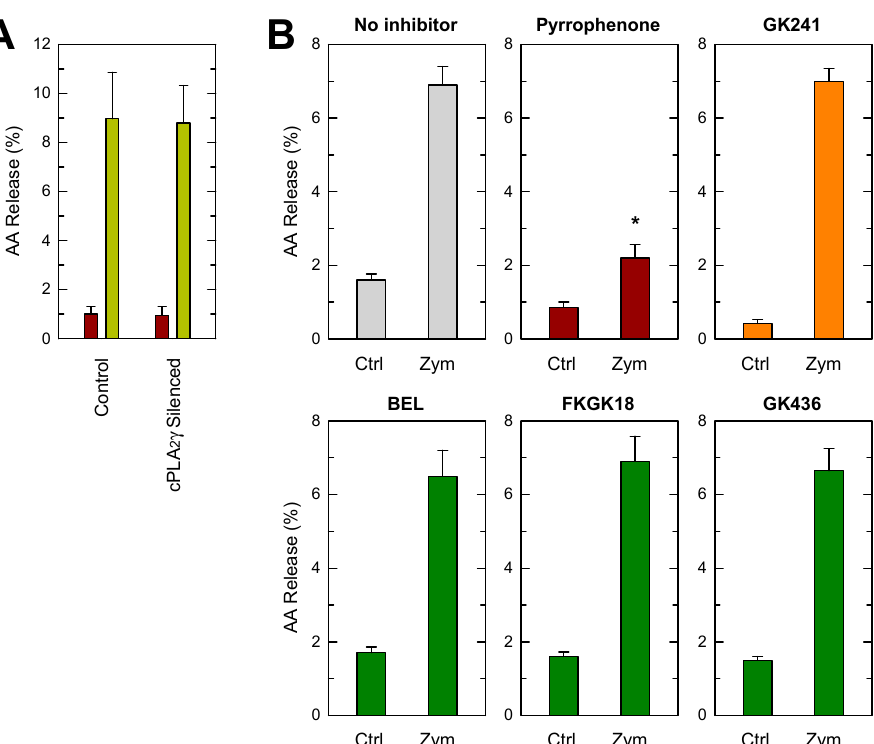
Figure 8. Stimulated AA mobilization in RAW 264.7 cells: ( A ) [ 3 H]AA-labeled cells, treated with a scrambled siRNA (Control) or siRNA for cPLA 2 γ (cPLA 2 γ Silenced), were left untreated (dark red bars) or treated with 150 µ g / mL zymosan (dark yellow bars) for 1 h. ( B ) The cells, labeled with [ 3 H]AA, were preincubated with either 2 µ M pyrrophenone, 10 µ M GK241, 5 µ M bromoenol lactone (BEL), 10 µ M FKGK18, 5 µ M GK436, or neither (no inhibitor) for 30 min. Afterward they were untreated (Ctrl) or treated with 150 µ g / mL zymosan for 1 h. Results are shown as means ± S.E.M. (n = 3). * p < 0.05, significantly different from zymosan-stimulated cells in the absence of inhibitors.